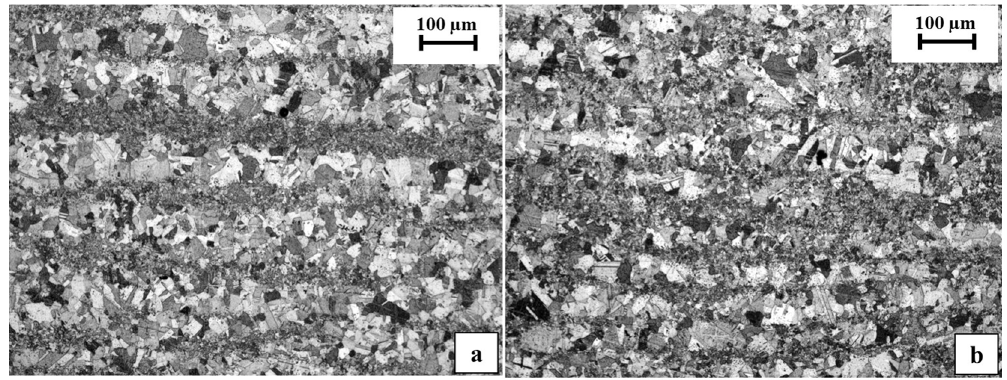
Figure 6. TiAl microstructure ( a ) near the diffusive interface with the nickel-based alloy; ( b ) far from the interface.